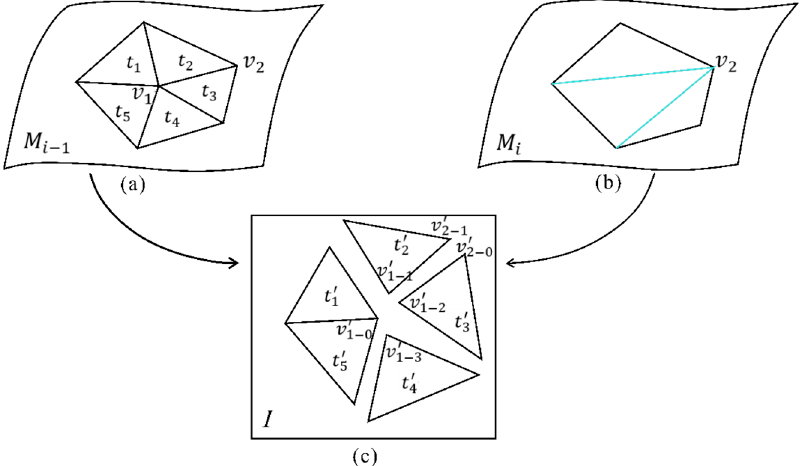
Figure 2. Mapping relationship between meshes and textures. ( a ) 𝑀 (cid:2919) (cid:2879) (cid:2869) is the original mesh in 3D space, and 𝑡 (cid:2869) – 𝑡 (cid:2873) are five adjacent facets. ( b ) 𝑀 (cid:3036) is a simplified mesh after the half-edge collapse (𝑣 (cid:2869) , 𝑣 (cid:2870) ) → 𝑣 (cid:2870) . ( c ) 𝐼 represents the 2D texture space, 𝑡 (cid:2869)(cid:4593) ~– is the patch corresponding to 𝑡 (cid:2869) – 𝑡 (cid:2873) in the texture space, and 𝑣 (cid:2869) (cid:2879) (cid:2868)(cid:4593) – 𝑣 (cid:2869) (cid:2879) (cid:2871)(cid:4593) and 𝑣 (cid:2870) (cid:2879) (cid:2868)(cid:4593) – 𝑣 (cid:2870) (cid:2879) (cid:2869)(cid:4593) are the corresponding points of 𝑣 (cid:2869) and 𝑣 (cid:2870) in 𝐼 , re- spectively.